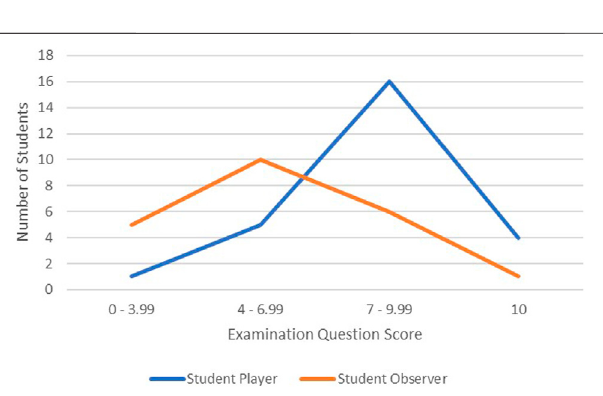
FIGURE 4 | The examination question performance between student player and observer